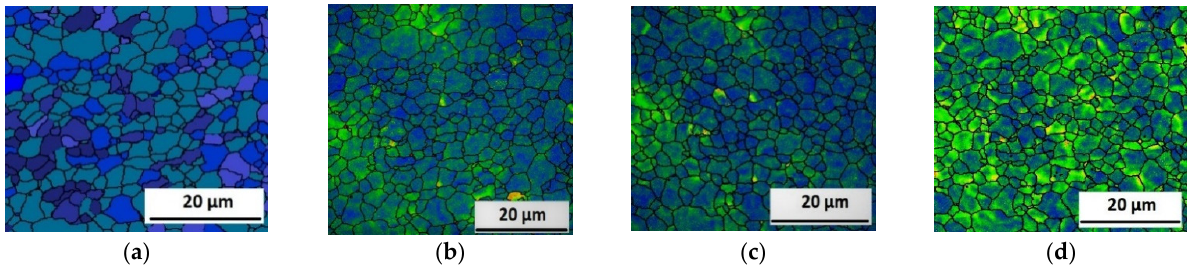
Figure 6. EBSD color map of high-temperature ECAPed Aluminum after ( a ) no pass, ( b ) first pass, ( c ) second pass, ( d ) third pass.